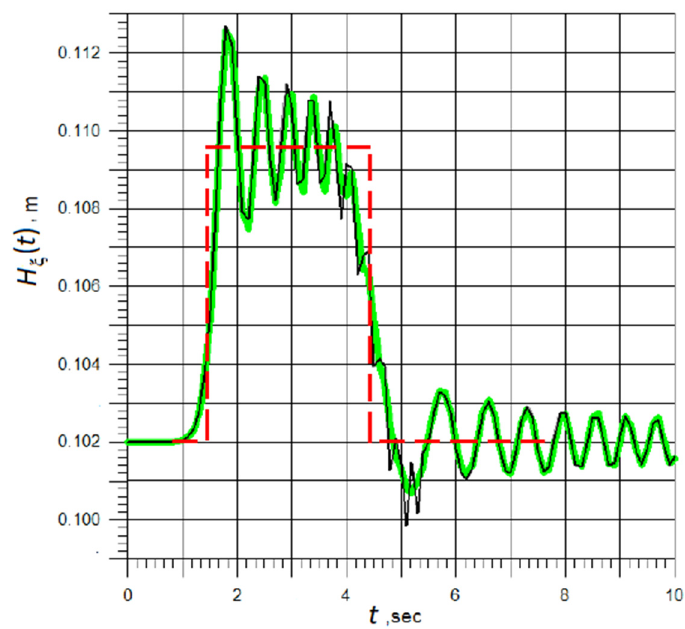
Figure 6. Comparison of experimental dependence wave height—time (green line) ξ ( t ) = H ξ ( t ) − H with the numerical calculation for ideal generator (black line) at a distance of 1.5 m from the front wall of wave generator. The red dashed line is the model wave profile.